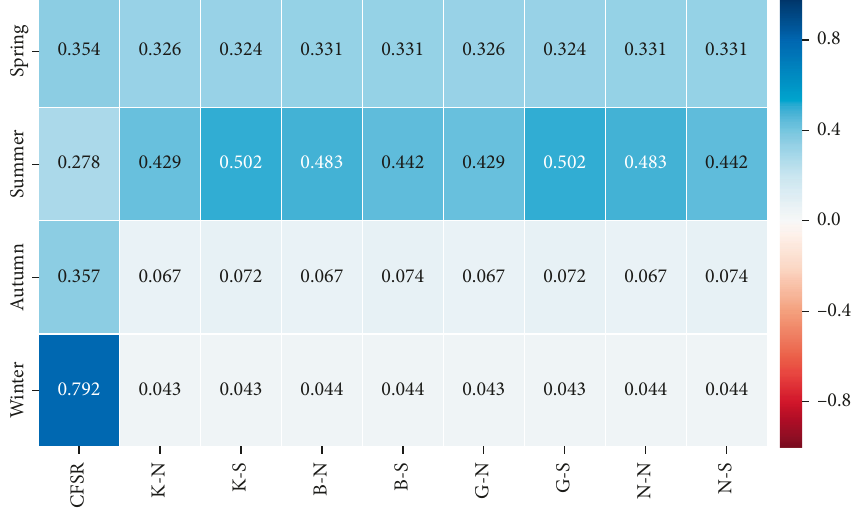
Figure 11: The same as Figure 10, but for latent heat